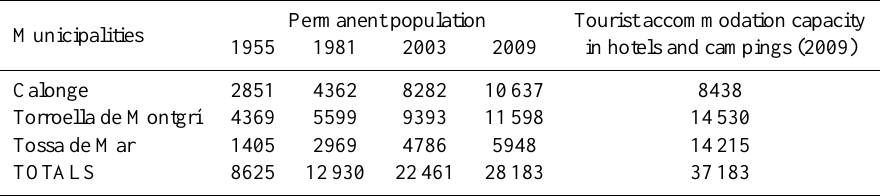
Table 1. Population change and tourist accommodation capacity in studied municipalities (Source: Institut d’Estad´ıstica de Catalunya,